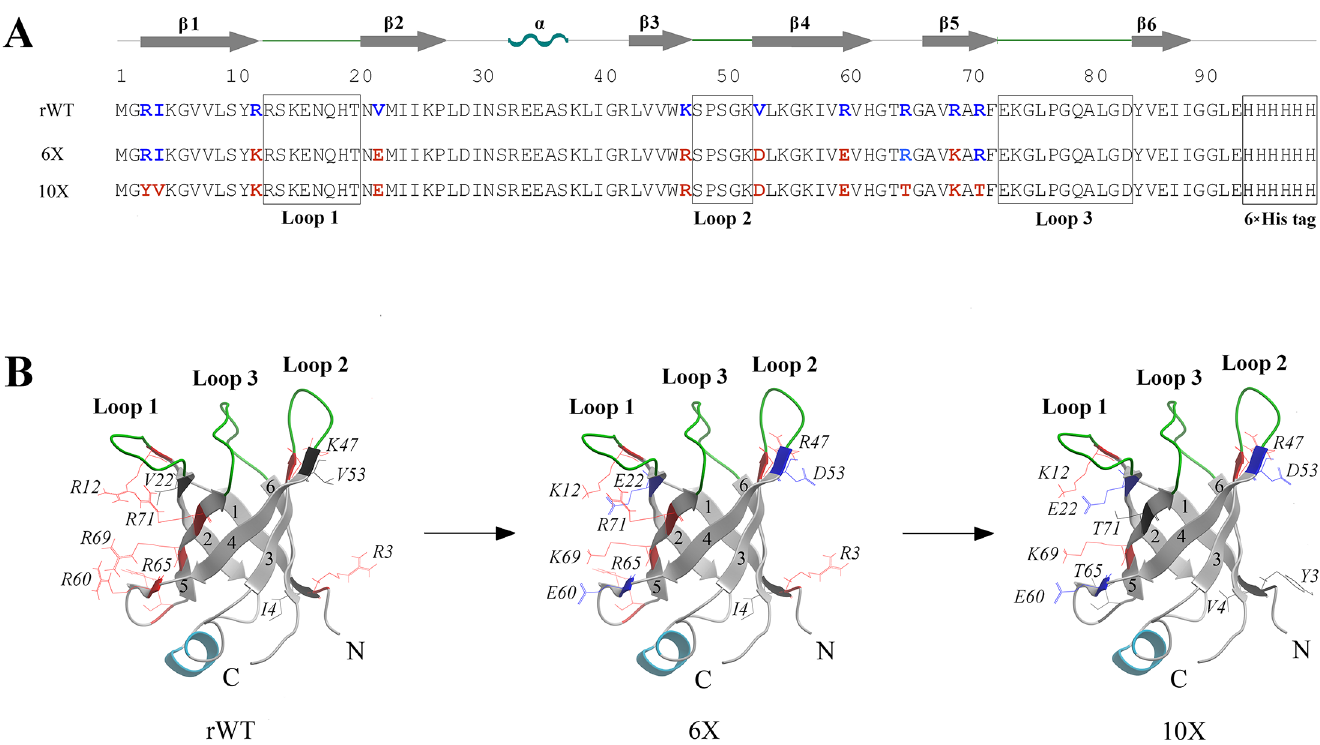
Fig 1. Amino acid sequences (A) and structural models (B) of the recombinant forms of L35Ae from P . horikoshii used in the present study. (A) Secondary structure elements for tertiary structure of L35Ae from P . furiosus (PDB entry 2lp6 [50]) are indicated. The loop regions mimicking CDRs of immunoglobulins and a 6xHis tag are shown in rectangles. The residues affected by mutagenesis are indicated using bold color font. (B) The β -sheets from 1 to 6 (grey) and CDR-like loop regions (green) are indicated. The residues affected by mutagenesis are shown using wire representation. The structural models of L35Ae forms were built based on PDB entry 2lp6 [50]. The figure was created using ICM Browser v.3.7-3b (MolSoft L.L.C.)